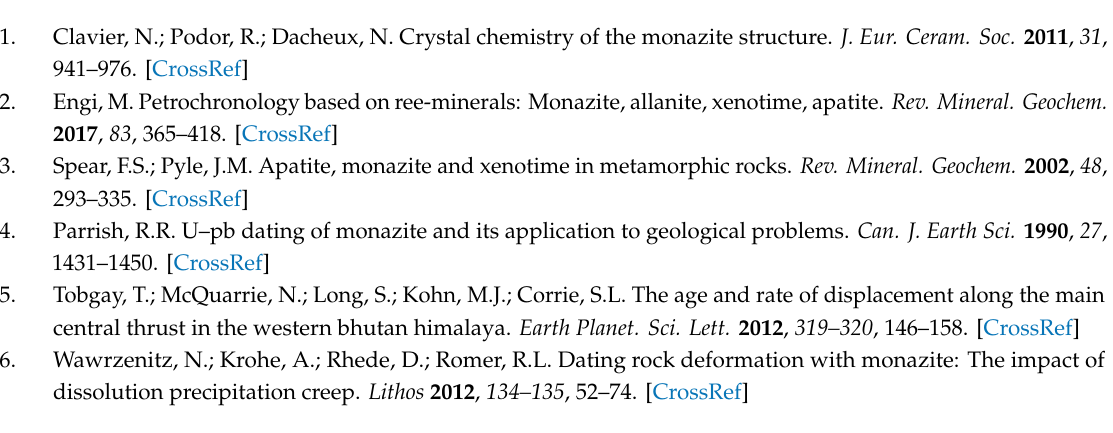
Figure S1. Correction factor for each U-Th / Pb ratio relative to USGS 44069 for 10 µ m and 10 Hz of analytical session 120605 for all monazite RMs. The correction factor for U-Th / Pb remains the same for each monazite analysed. The uncertainty of the Th / Pb and U / Pb correction factor ranges between 2% to 4%, whereas for Pb / Pb it only varies by 1%, indicating that each monazite sample tested here is suitable as calibration RM. Attention has to be paid using Moacir due to age uncertainties. Table S1: U / Pb and Th / Pb data (age and raw ratios) of all runs for each monazite reference sample. Data shows the U-Th / Pb data of the in-house Excel spreadsheet. *Analytical sessions (120605, 130807, 130905) were carried out at the Johannes